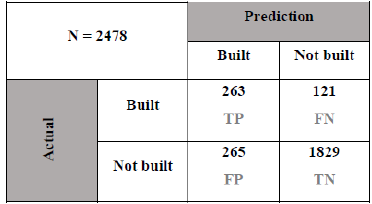
Table 4. Accuracy assessment for the case of Nov. 13, 2016